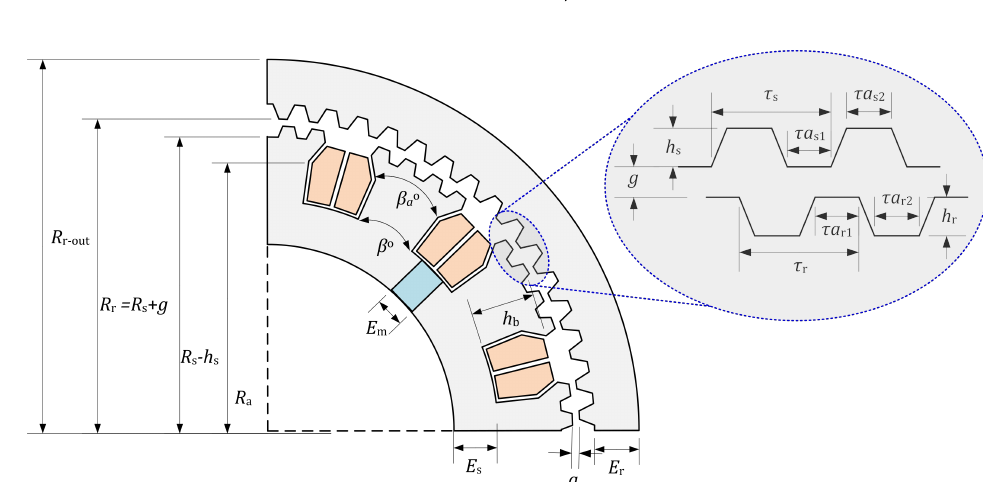
Figure 3. Detailed topology view of the examined